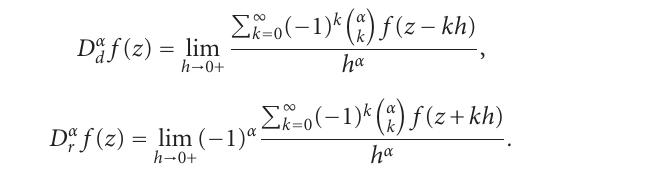
Figure 2.1. Integration paths and poles for the integral representation of fractional order di ff erences. Gr ¨ unwald-Letnikov